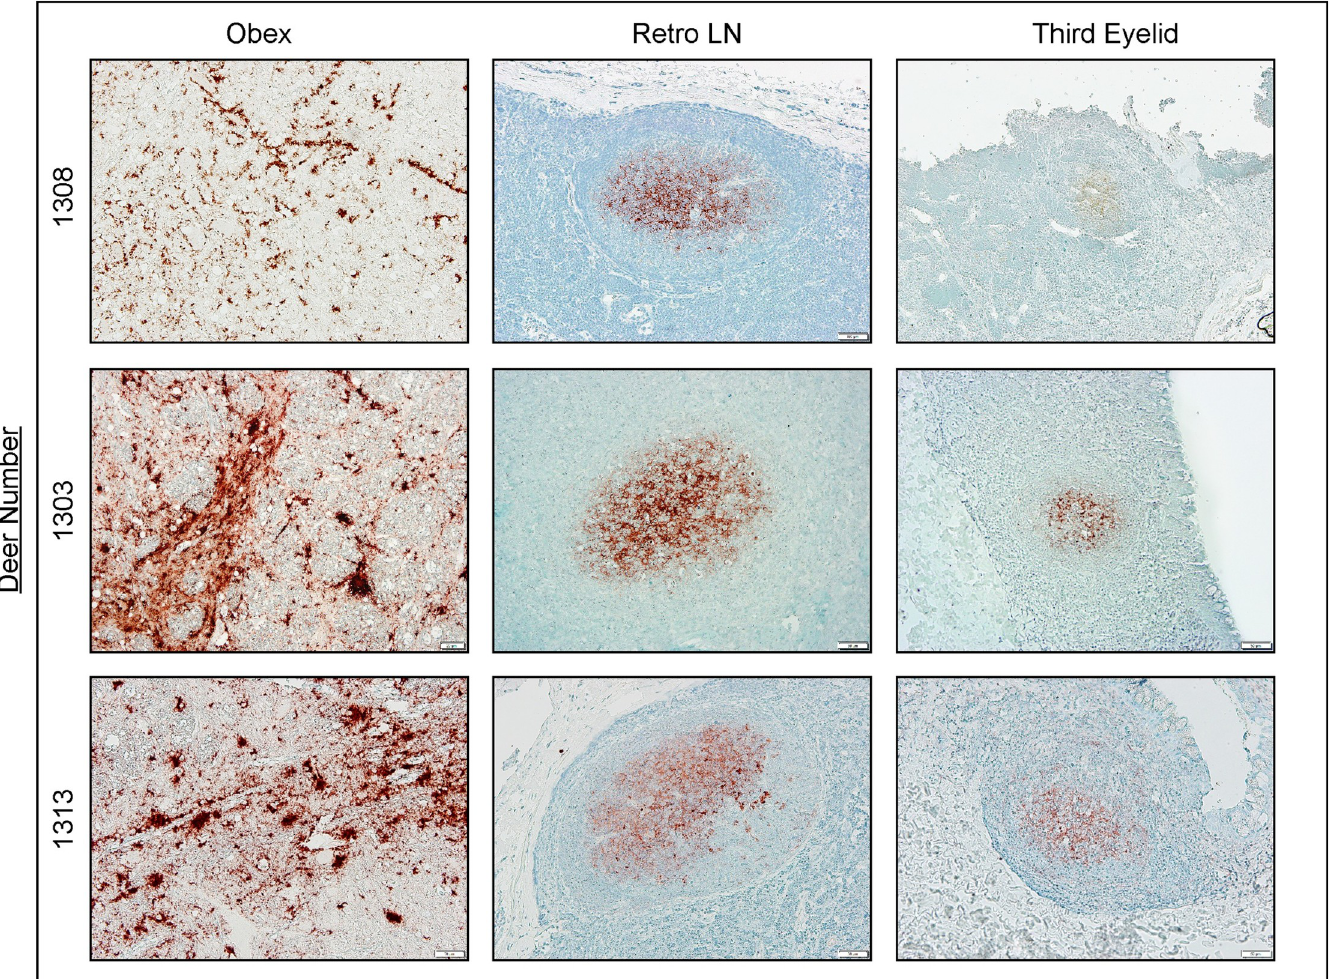
Fig 2. Detection of PrP CWD in terminal 96GG deer by IHC. PrP CWD immunoreactivity was present in plaques in the obex and in germinal centers of lymphoid follicles of the retropharyngeal lymph node and third eyelid. Displayed are 3 positive deer of the 10 deer assayed by both IHC and RT-QuIC. IHC images are 200X magnification; scale bar = 50 μ m. Abbreviations: Retro LN, retropharyngeal lymph node; IHC, immunohistochemistry.